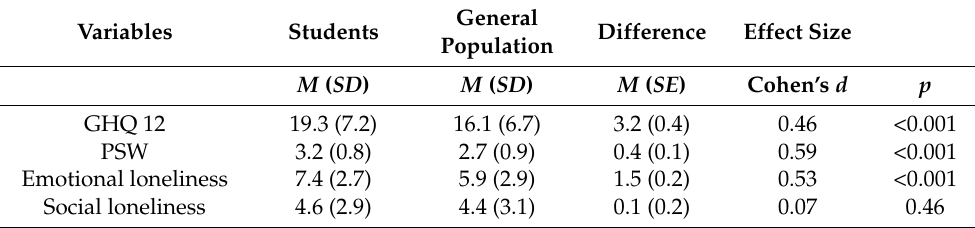
Table 2. The students’ and the general populations’ mental health, well-being and loneliness.